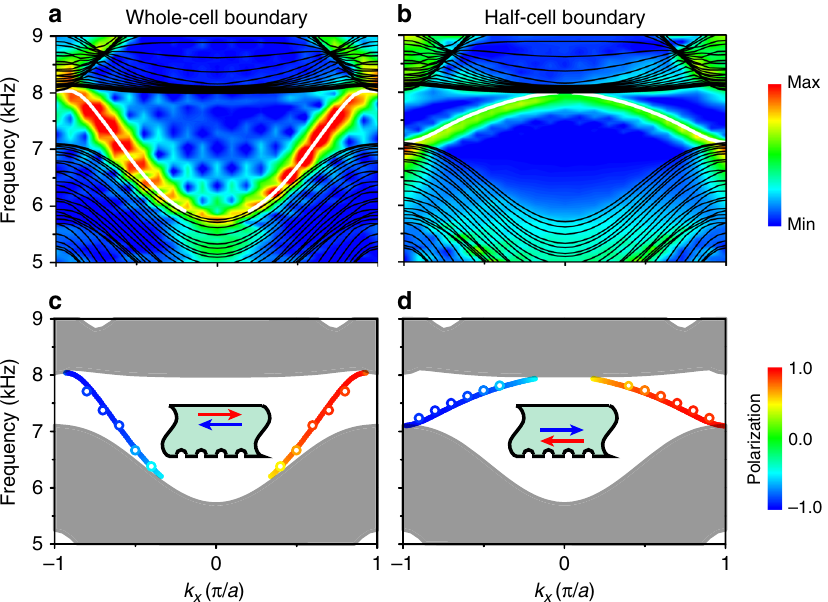
Fig. 3 Acoustic helical boundary waves. a , b The dispersions of helical boundary waves on the whole-cell and half-cell boundaries, respectively. The color maps denote the measured data, and the white and black lines represent the simulated dispersions of the boundary states and projected bulk states, respectively. c , d The spin polarizations of the boundary waves for the whole-cell and half-cell boundaries, respectively (lines for simulations and circles for experimental results). Inset: the red (blue) color of arrows denotes spin up (down). A pair of gapless boundary waves with opposite spin polarizations counterpropagate along the